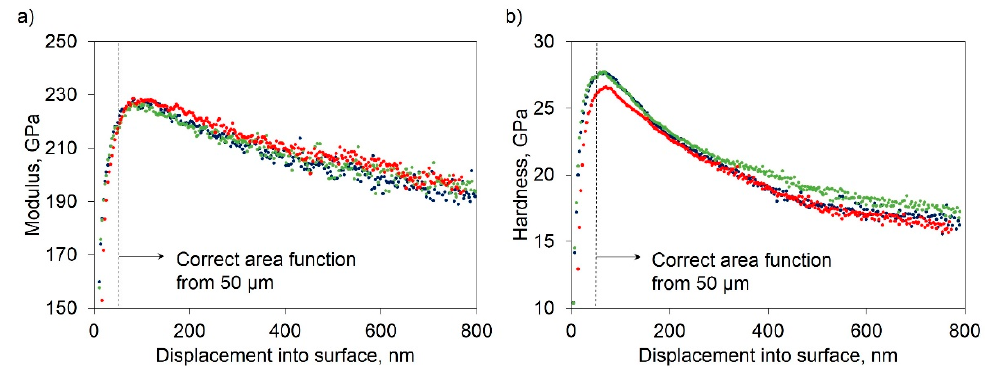
Figure 6. Measured curves of ( a ) modulus and ( b ) nanoindentation hardness of the SFCA crystals in sample PM-F.